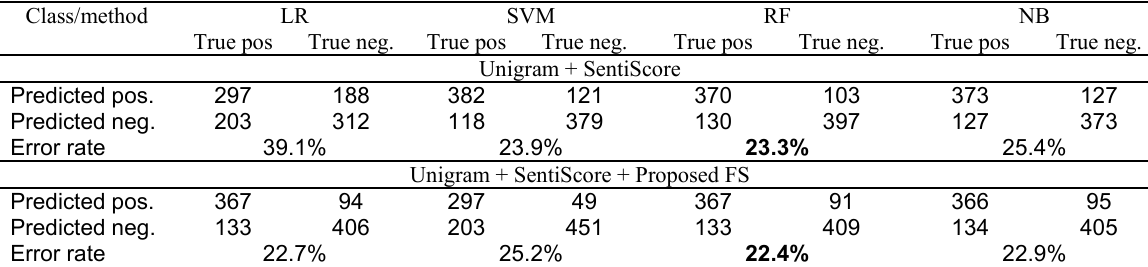
Table 11. Confusion Matrix of Yelp Restaurant